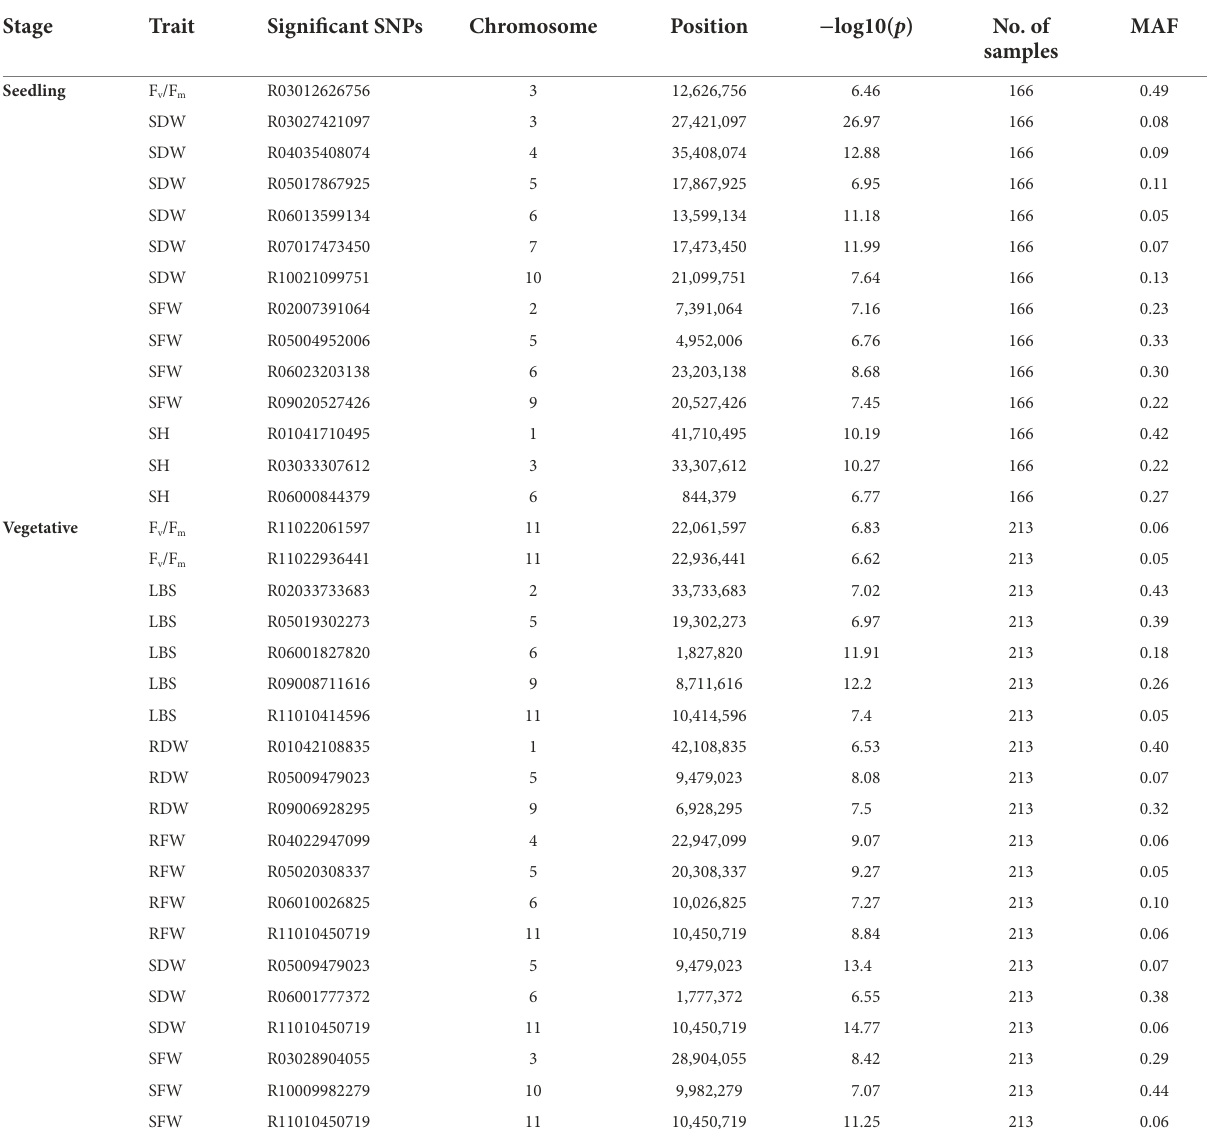
TABLE 1 Associated SNPs for various traits determined at seedling and vegetative